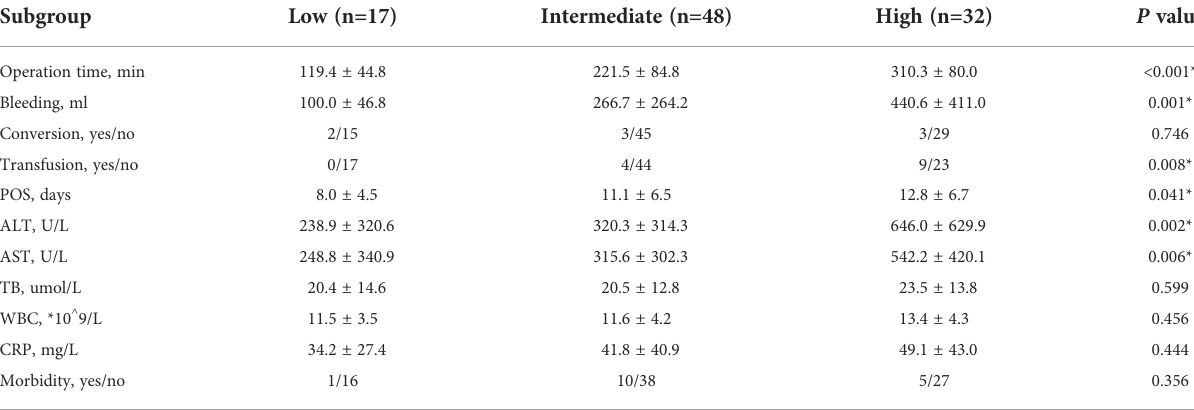
TABLE 4 Surgical outcomes according to the novel dif fi culty scoring system (n=97).